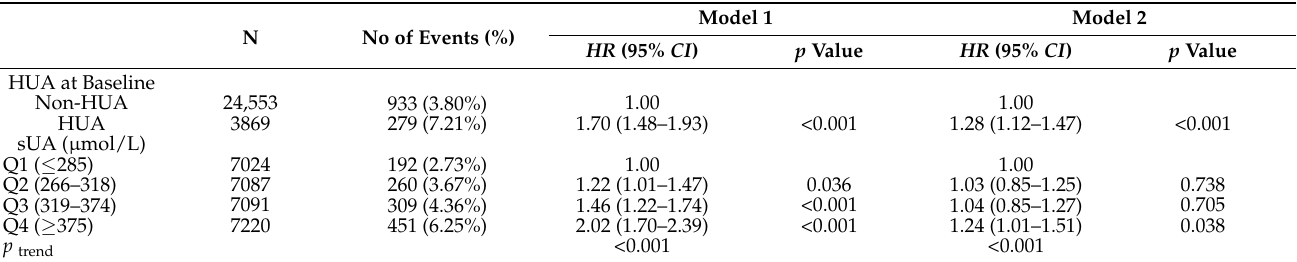
Table 2. Associations between HUA and sUA at baseline with new-onset